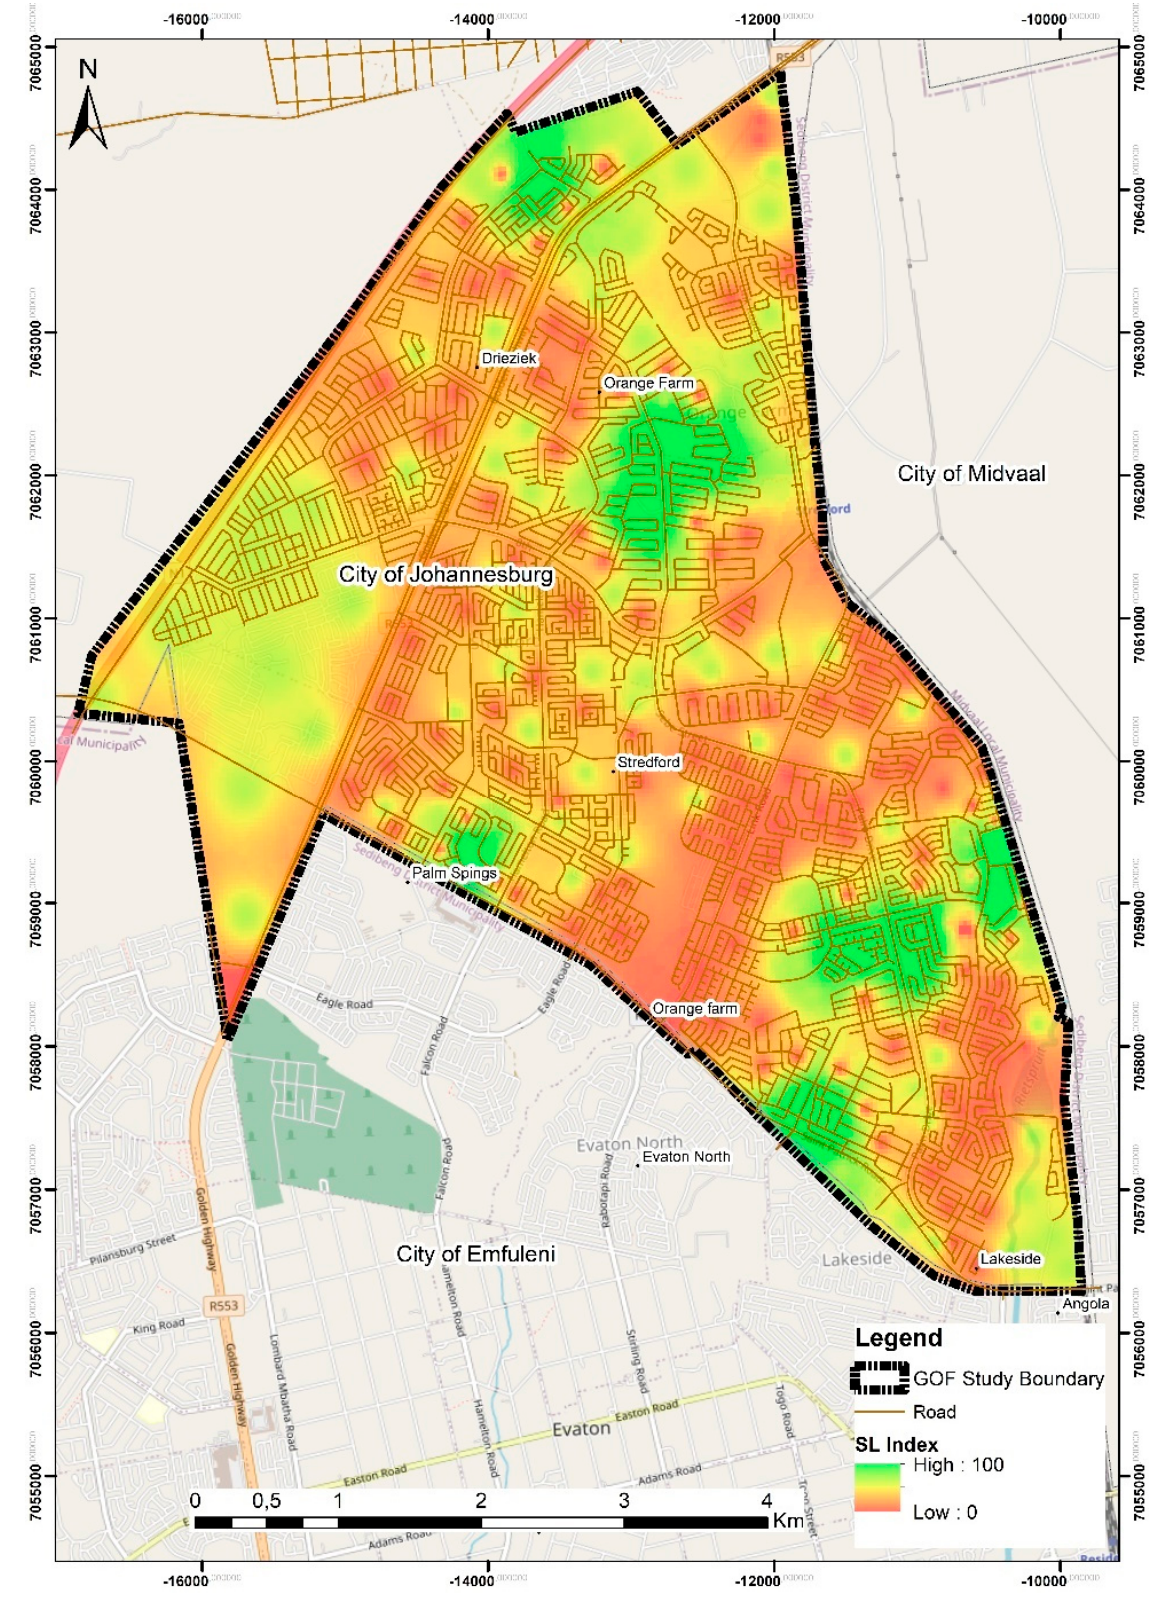
Figure 2. Strategic land index for GOF.